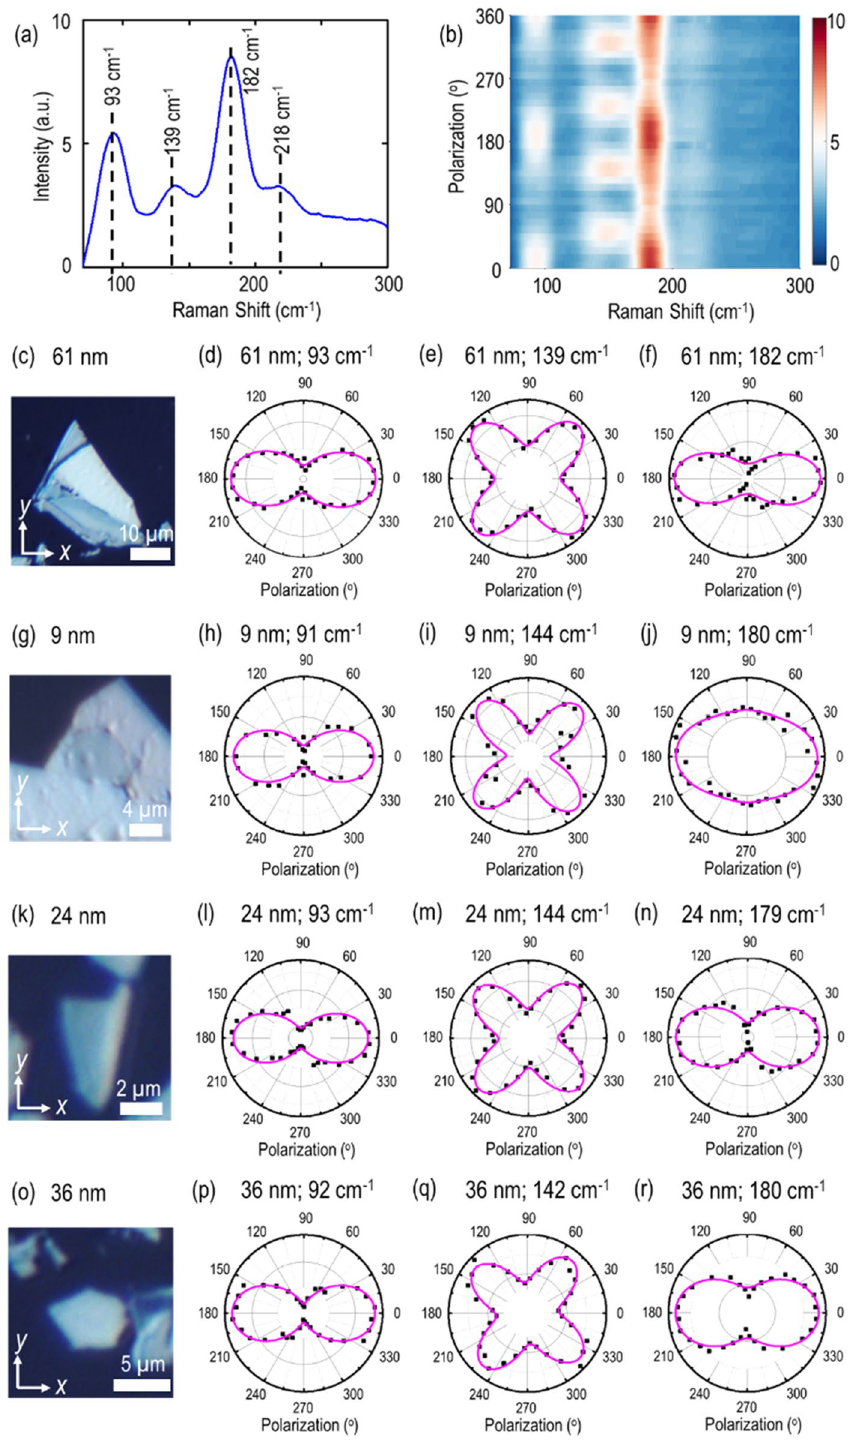
Figure 3. ( a ) Collected Raman spectrum for the 61 nm-thick teallite flake. The observed Raman modes are indicated with vertical black dashed lines. ( b ) Color map of angle-resolved Raman spectra in parallel polarization configuration for the 61 nm flake. ( c , g , k , o ) Captured optical microscope reflection images of the investigated 61, 9, 24 and 36 nm thick teallite crystals. ( d – f ) Polar plots of Raman intensities for different Raman modes at 93, 139 and 182 cm −1 in parallel polarization configuration for the 61 nm flake. ( h – j , l – n , p – r ) Polar plots of Raman modes for other teallite flakes of 9, 24 and 36 nm. Black squares are the experimental data, whereas magenta solid lines indicate the theoretical